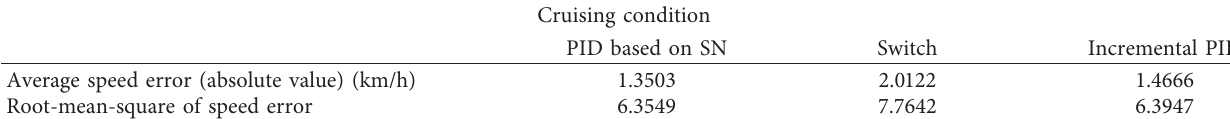
Table 15: Performance in the cruising condition.